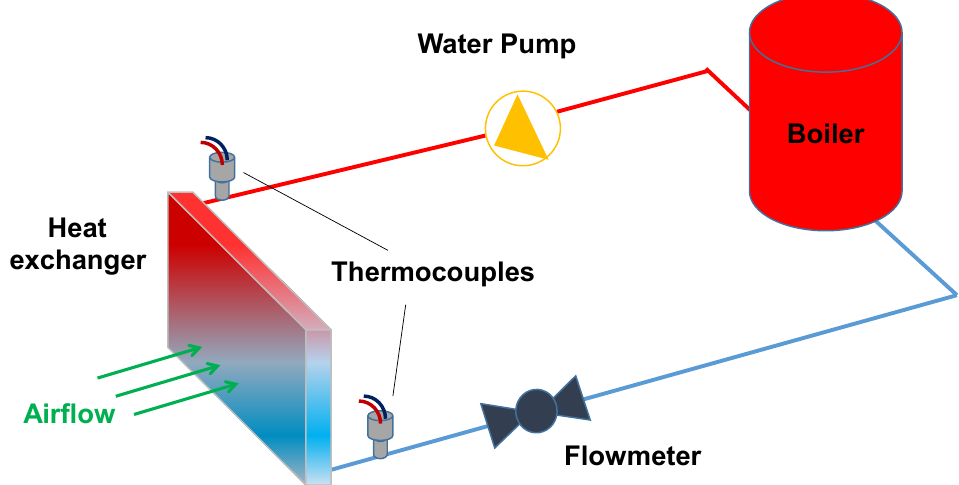
Figure 7. Schematic of the experimental setup used to measure the thermal performance of a heat exchanger.